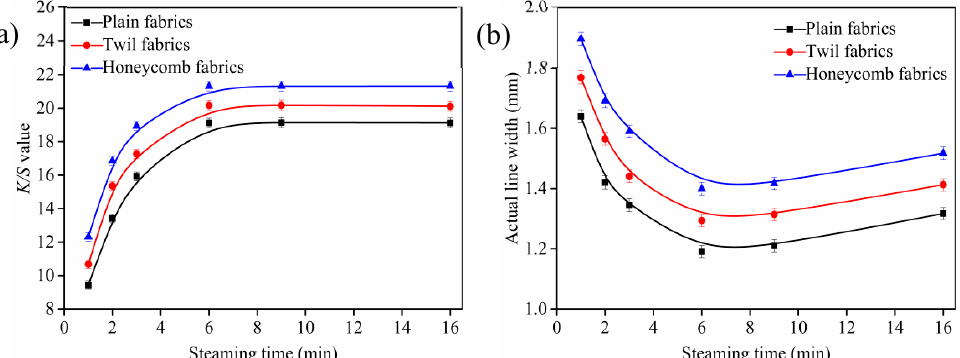
Figure 5. Effect of steaming time on K / S values ( a ) and outline sharpness ( b ), fabric was printed with cyan as a rectangle pattern of 80 × 150 mm and lines of 1 mm. All the pickup of fabrics were (70 ± 1)%, and steaming temperature was (102 ± 1) °C.